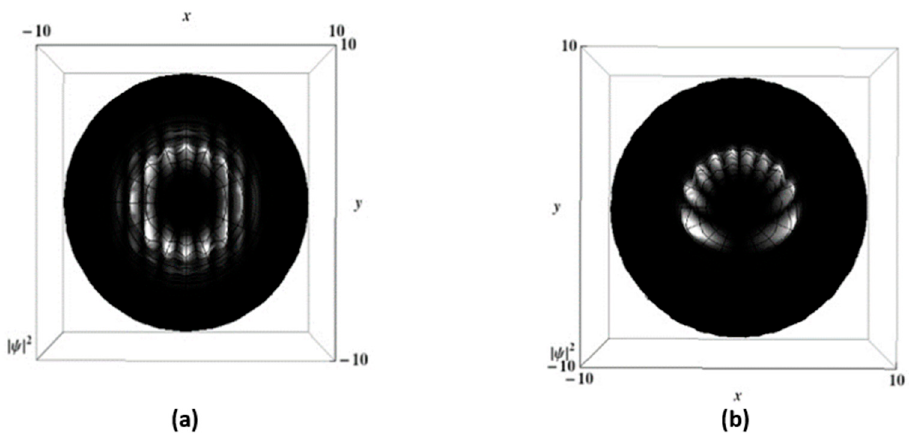
Figure 3. Superposition of optical vortices with a phase tilt. ( a ) Equally charged with 𝑚 = 5 to produce interference fringes; ( b ) Oppositely charged vortices with m 1 = 5 and m 2 = − 5 overlapped overlapped to produce interference fringes. ( b ) Oppositely charged vortices with 𝑚 (cid:2869) = 5 and 𝑚 (cid:2870) = to produce a firebird −5 overlapped to produce a firebird pattern.